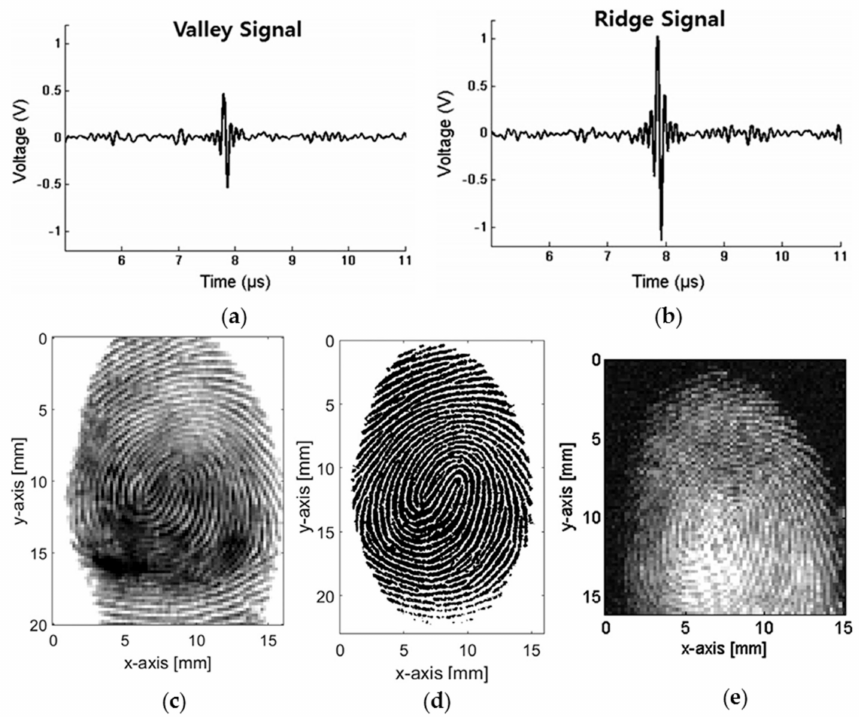
Figure 8. PA generation from ( a ) valley and ( b ) ridge portions of the finger; fingerprint images obtained by ( c ) ultrasonic pulse-echo impedance mismatch method, ( d ) ink-press method, and ( e ) PA method. Reprinted with permission from